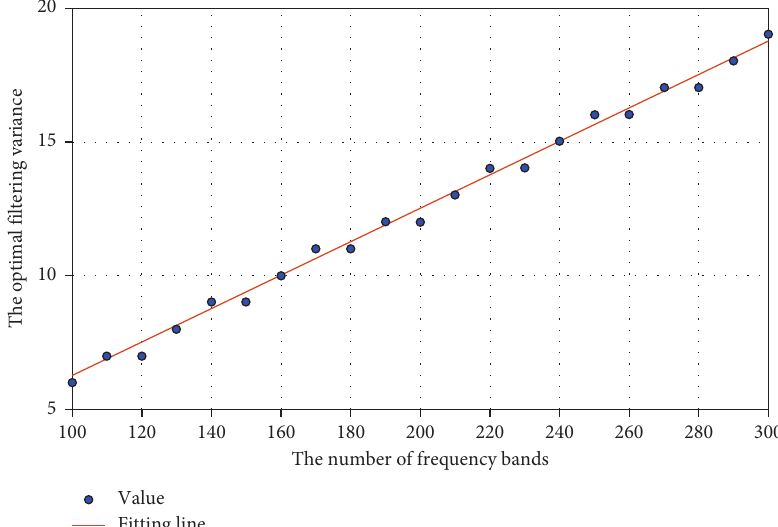
Figure 8: Relationship between the number of frequency bands and the optimal filtering